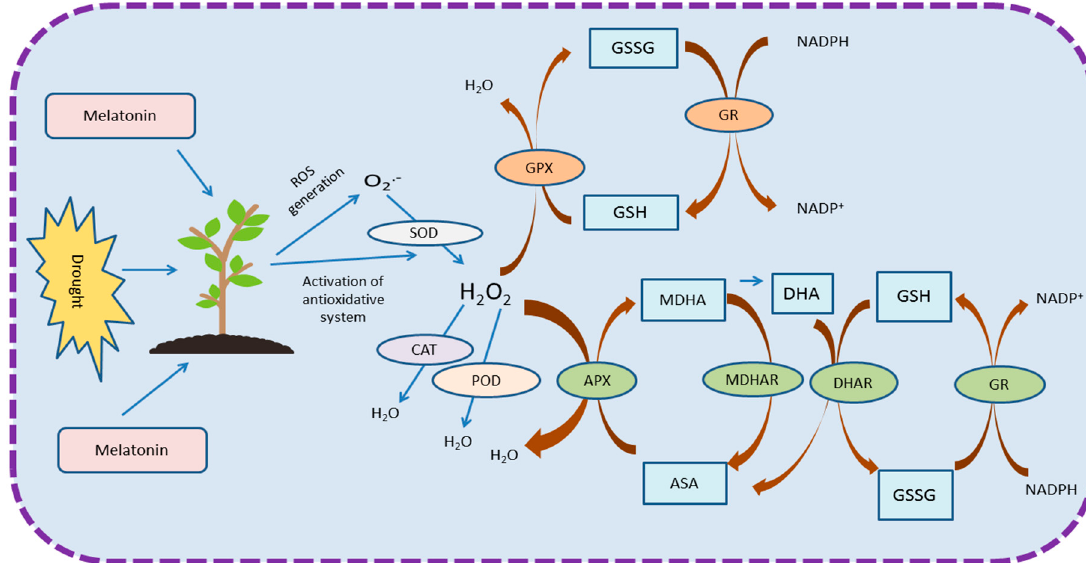
Figure 2. Diagrammatic explanation of the melatonin regulated anti-oxidative system and scavenging of reactive oxygen species. This diagram is a conclusion of various studies mentioned in Table 3.